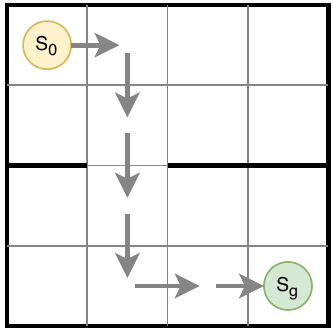
Figure 7. An example option, which takes the agent from the initiation state S 0 located in one room, to the termination state S g in another